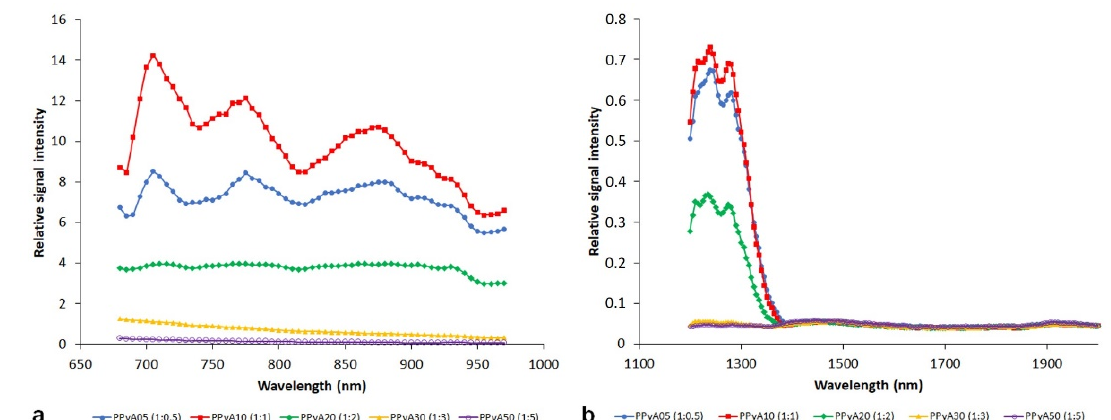
Figure 3. Photoacoustic spectra of polypyrrole nanoparticles prepared with APS oxidant. Different pyrrole and APS ratios are presented at 680–970 nm ( a ) and 1200–2000 nm ( b ) ranges. NP concentration was 3 mg/mL.